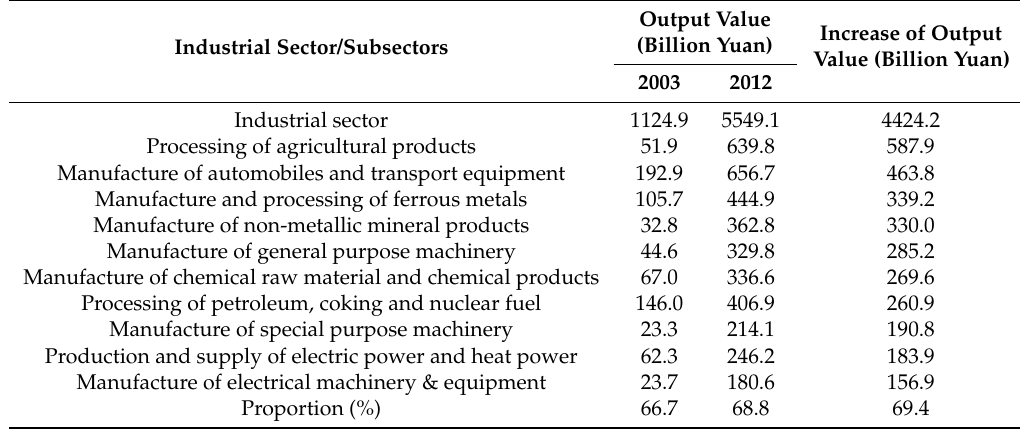
Table 3. Top 10 fastest growing industries during 2003–2012.